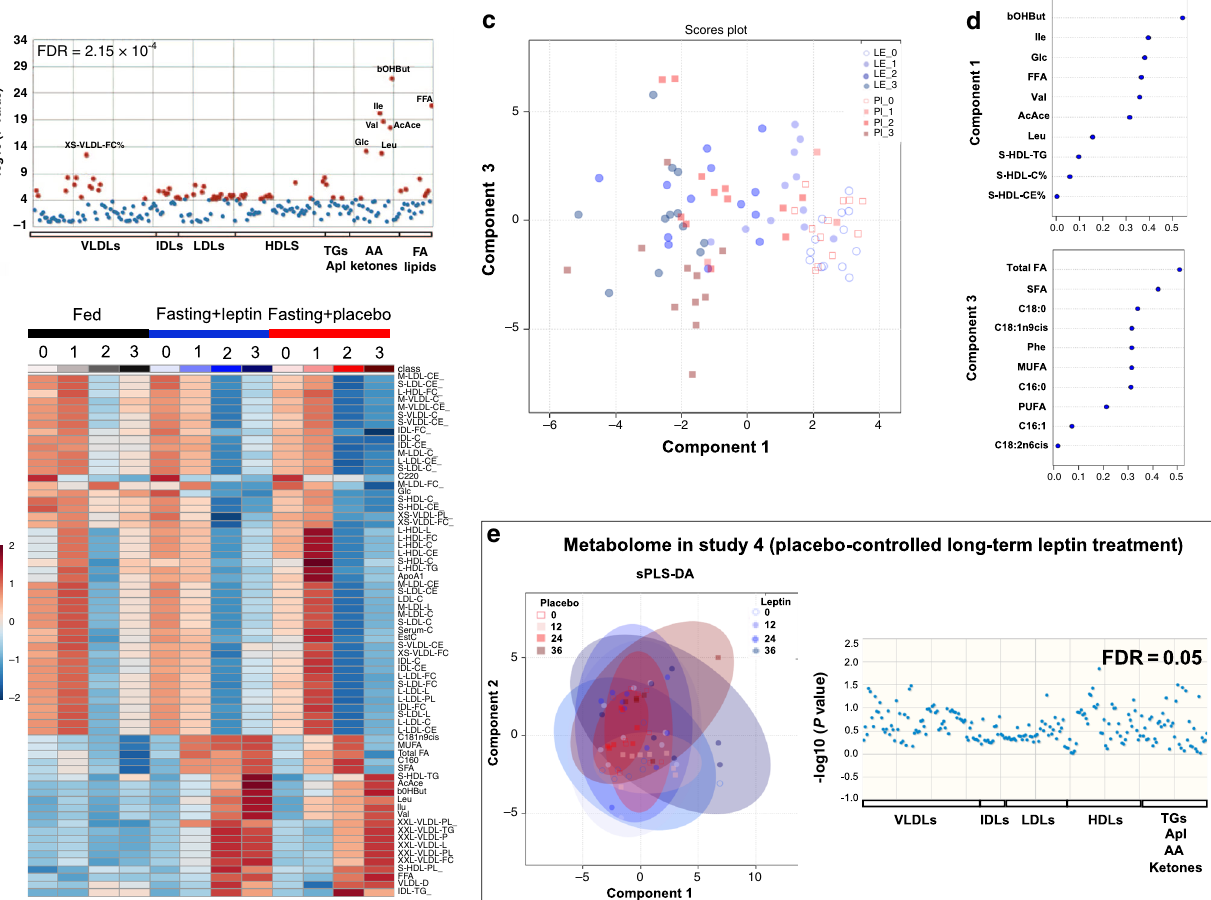
Fig. 6 Metabolome changes with short- and long-term leptin treatment. a – d Effects on metabolite and lipid metabolism of 72-h fed state or fasting treated with leptin or placebo (study 1, n = 13). a Evaluation of metabolites, lipids, and lipoproteins with one-way ANOVA between the three admissions. Red dots indicate parameters signi fi cantly different and blue dots parameters not signi fi cantly different between groups (fed vs fasting + placebo vs fasting + leptin) with a preset false discovery rate of P < 2.15 × 10 − 4 (total 68 parameters signi fi cant). b Heatmap of the 68 signi fi cant parameters according to one-way ANOVA for the three admissions. c sPLS-DA analysis of fasting + leptin vs fasting + placebo: symbols indicate the measurement of component 1 in relation to measurement of component 3 for one subject/on one treatment/on one day of fasting: Blue circles correspond to leptin and red squares to placebo. Increasing color intensity indicates more time (days) of fasting. d The ten parameters that compose components 1 and 3 and their level of contribution (loading) to the component. e Effects on metabolite and lipid metabolism of long-term leptin treatment in mildly hypoleptinemic women (placebo-controlled study 4, n = 19 (leptin = 10; placebo = 9)). Left: sPLS-DA analysis of metabolites and lipoproteins in placebo vs leptin. Symbols indicate the measurement of component 1 in relation to component 2 for one subject/on one treatment/on one day of study: blue circles correspond to leptin and red squares to placebo. Increasing color intensity of symbol indicates more time (weeks) of study. Large oval-colored shapes indicate 95% con fi dence interval for each group. The observed major overlap between groups suggests no signi fi cant differences between placebo and leptin. Right: Evaluation of metabolites and lipoproteins with one-way ANOVA in placebo and leptin-treated subjects for up to 36 weeks. Each dot represents a parameter (blue dot = nonsigni fi cant parameter, red = preset color for signi fi cant parameters but no such parameter was detected). NMR-based metabolomics were used to quantify amino acids, metabolites, and lipids bound to lipoproteins. GC/MS-EI was used to quantify fatty acid methyl esters. Le_0, Le_1 etc. indicate day 0 (baseline), 1 etc. of fasting + leptin. Pl_0, Pl_1 etc. indicate day 0 (baseline), 1 etc. of fasting + placebo. For metabolite nomenclature, see Supplementary Data